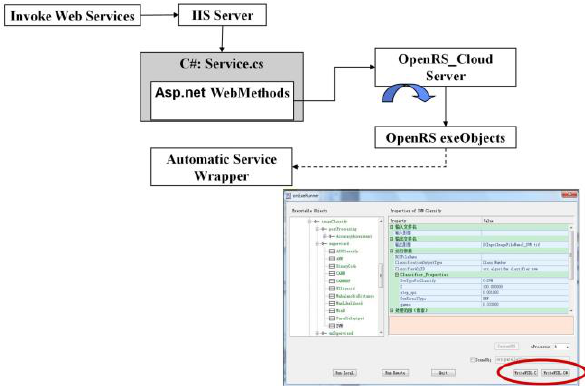
Figure 3. Wrapping algorithm as a Web service using